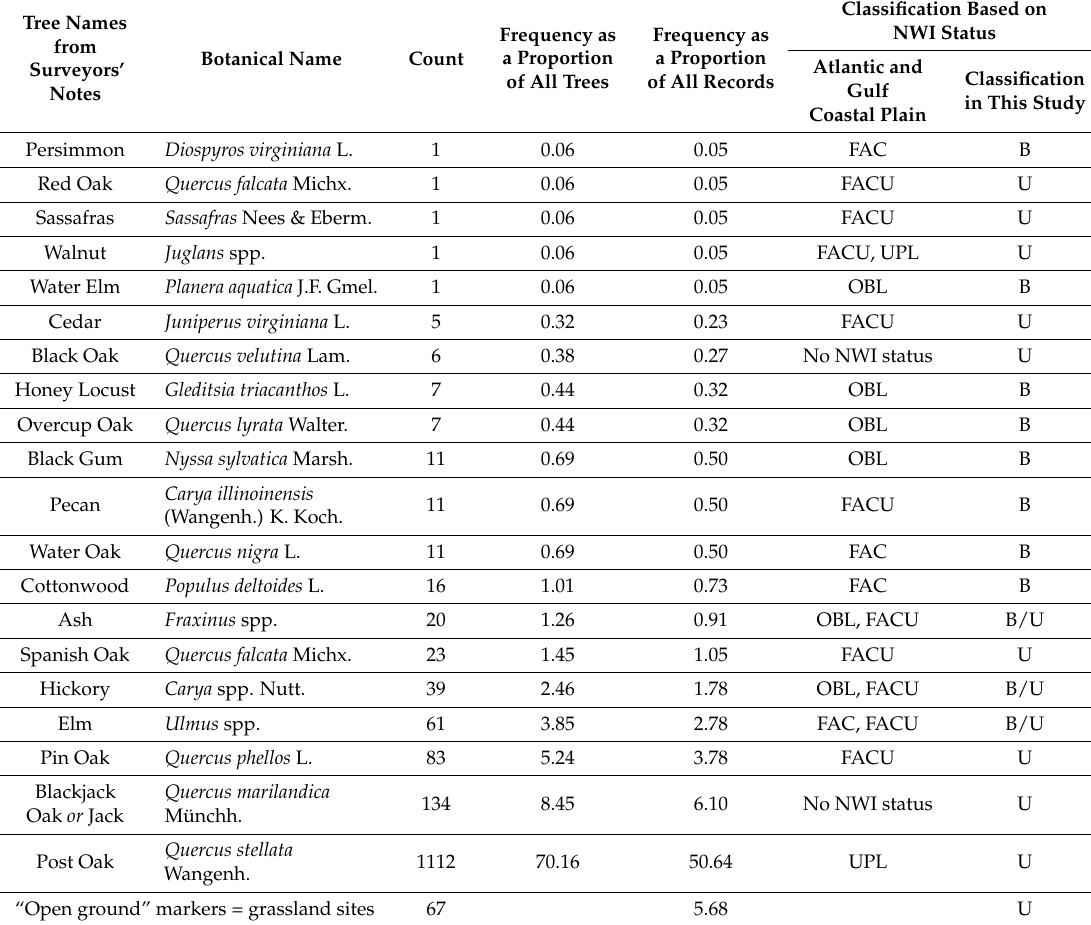
Table 2. Information on the witness trees recorded in the presettlement vegetation cover of Brazos